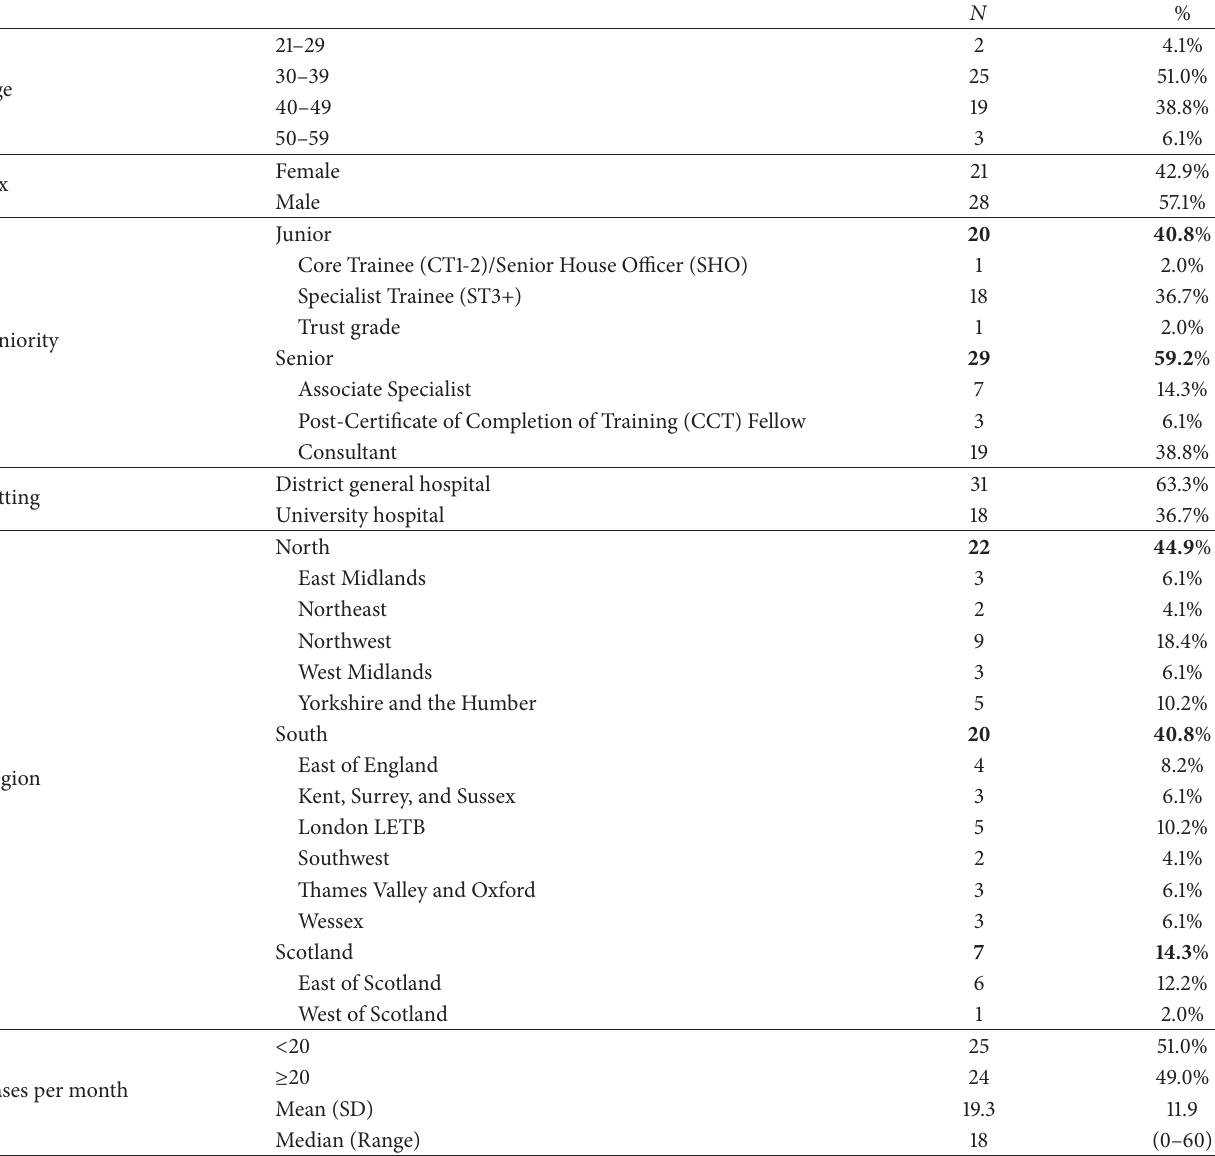
Table 1: Characteristics of Respondents who completed the survey in